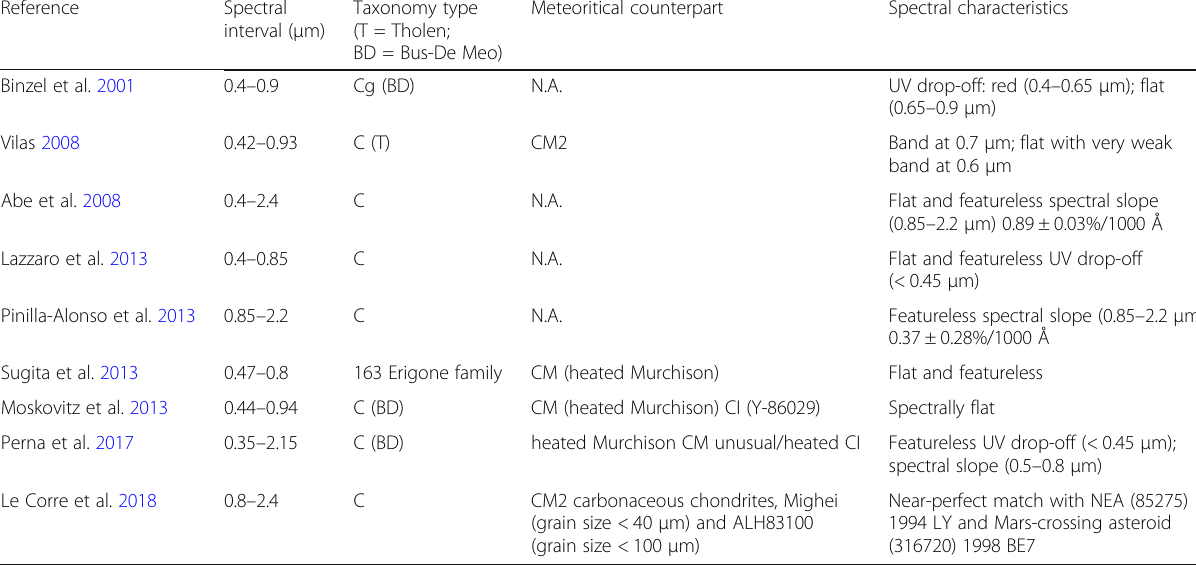
Table 4 Spectroscopic observations of asteroid Ryugu since its discovery in 2001. Spectral and compositional characteristics are listed Reference